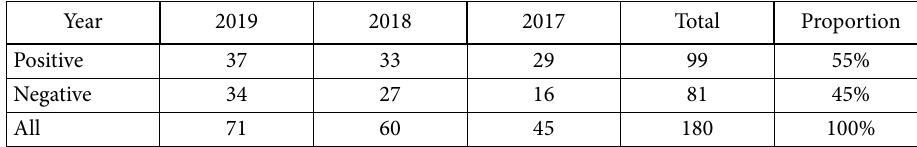
Table 2. Statistical chart of companies in financial trouble